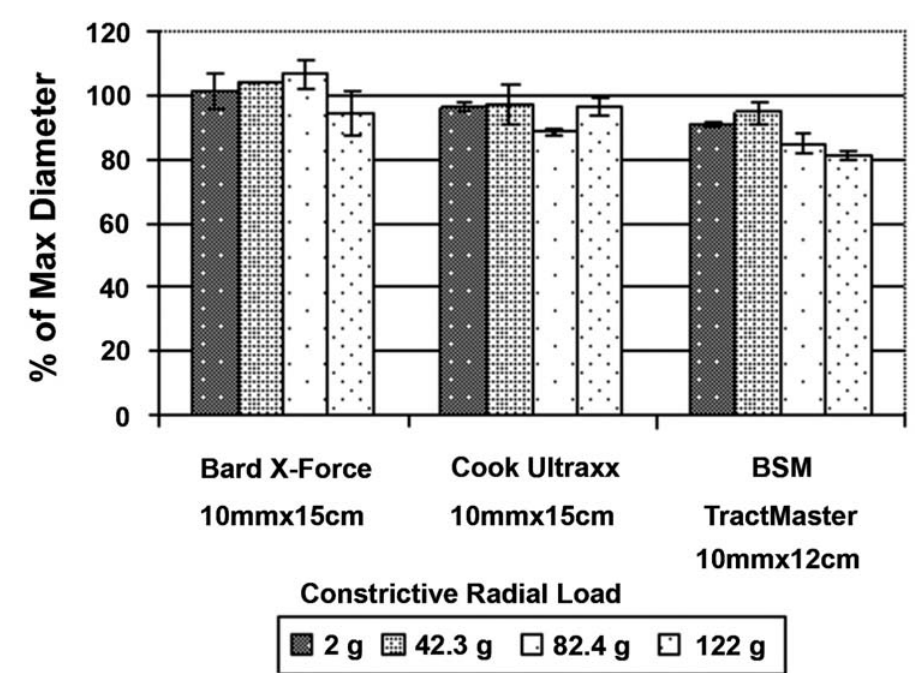
Figure 4 – Balloon dilation at burst All balloons performed well under low constriction forces and reached at least 80% of the